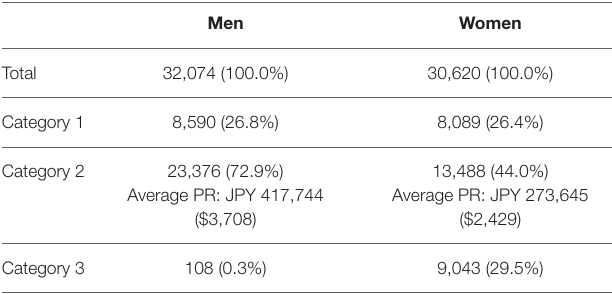
TABLE 1 | Contributions and benefits (per month). TABLE 2 | Numbers of subscribers by gender and category (in